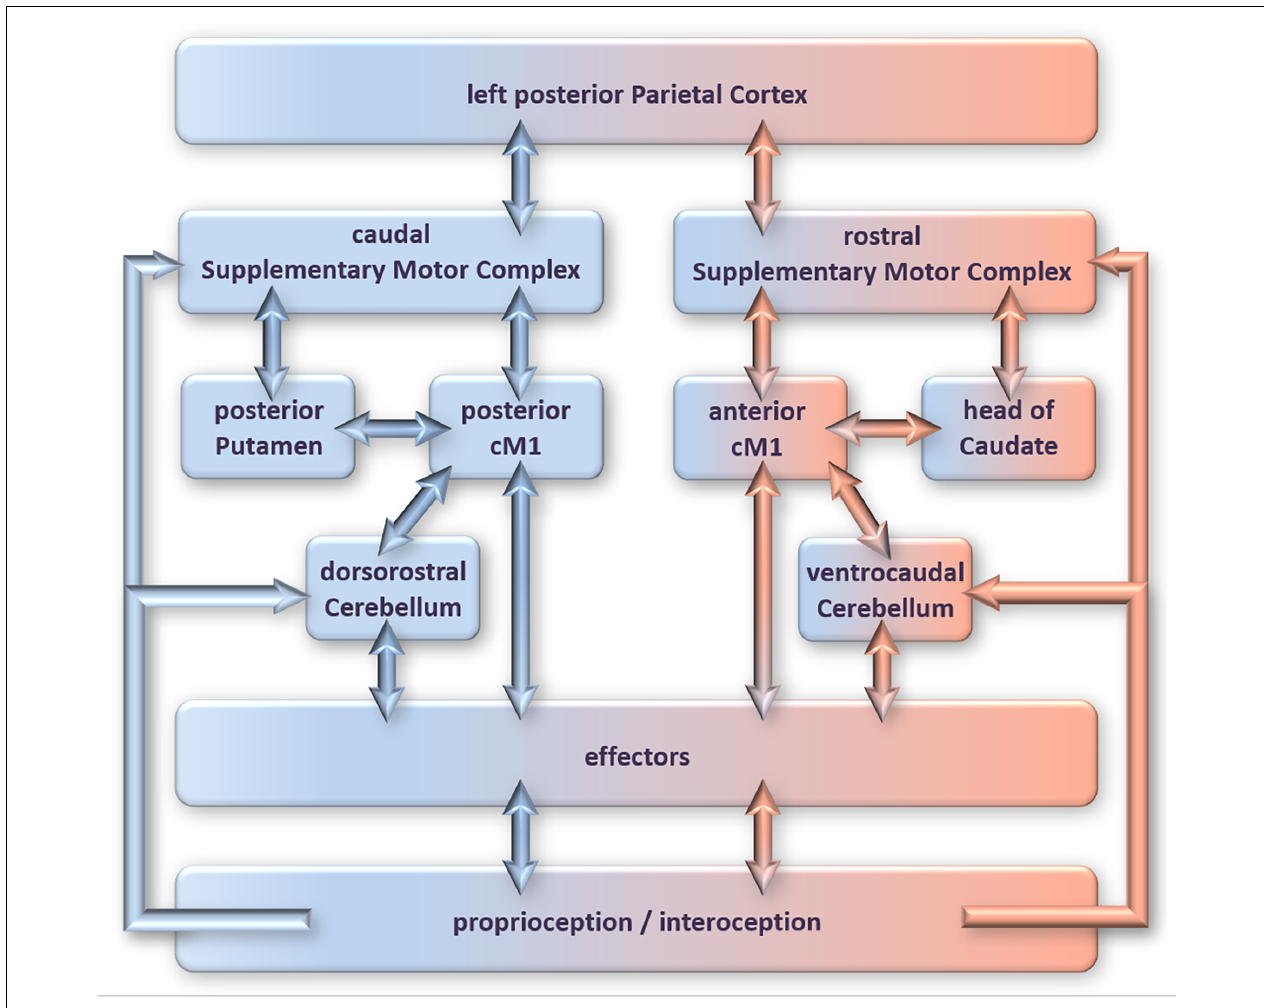
FIGURE 1 | The neural circuitry involved in overt motor performance (blue/left side of figure) compared to motor imagery (rose/right side of figure/nodes). Adopted from Ridderinkhof and Brass (2015); for details please refer to that